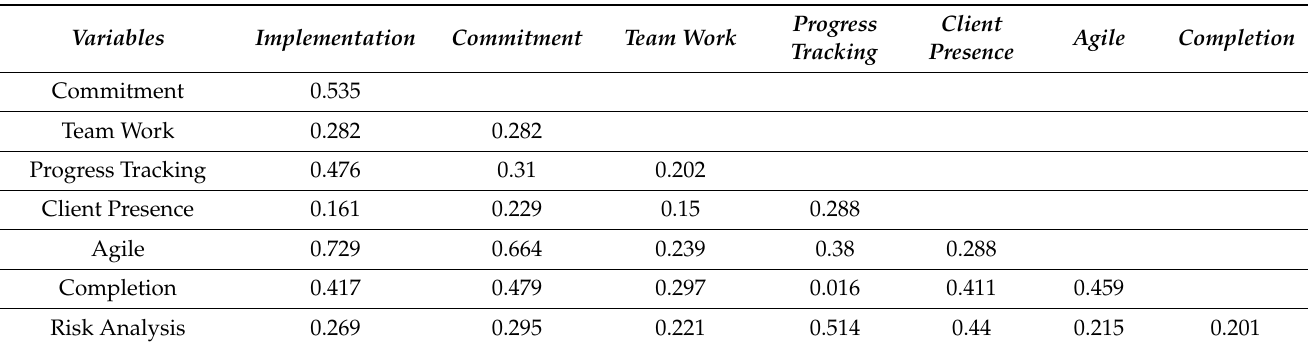
Figure 10. Teamwork and customer relationship under the lean methodology . Table 8. Agile correlation between the selected Table 8. Agile correlation between the selected variables .